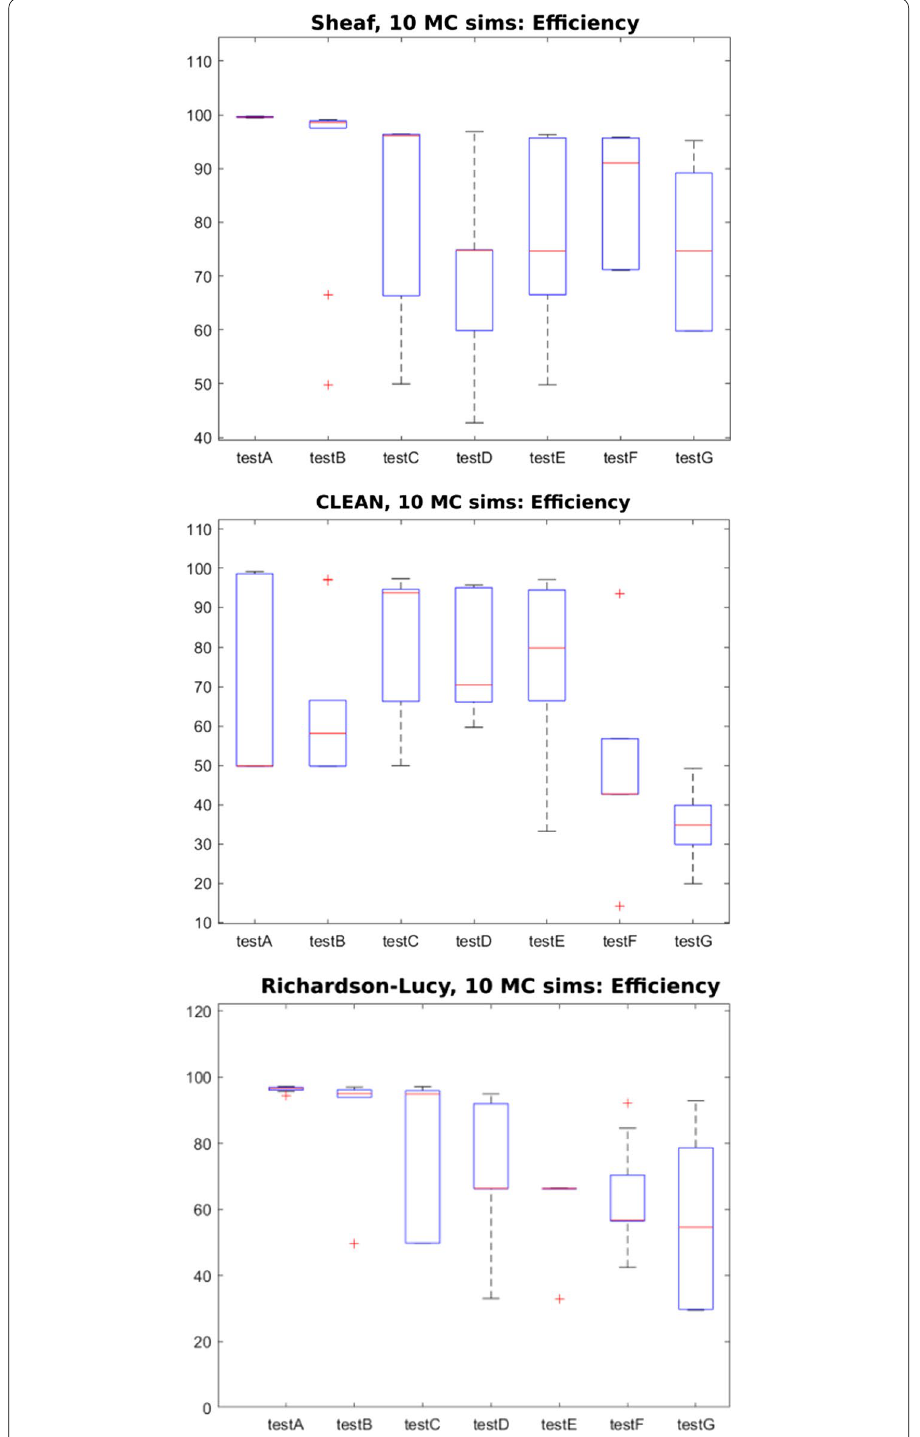
Fig. 9 Efficiency of the sheaf, CLEAN, and Richardson–Lucy algorithms split by Test (see Table 1). The vertical scales differ between frames to emphasize